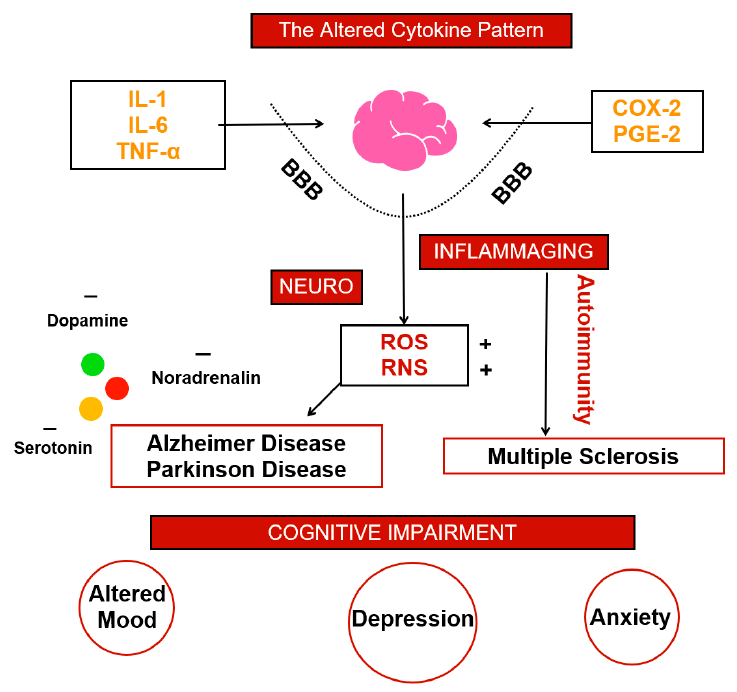
Figure 1. In Figure 1 we summarize the altered cytokine pattern at the basis of brain inflammation which in turn leads to cognitive impairment and mood modification.